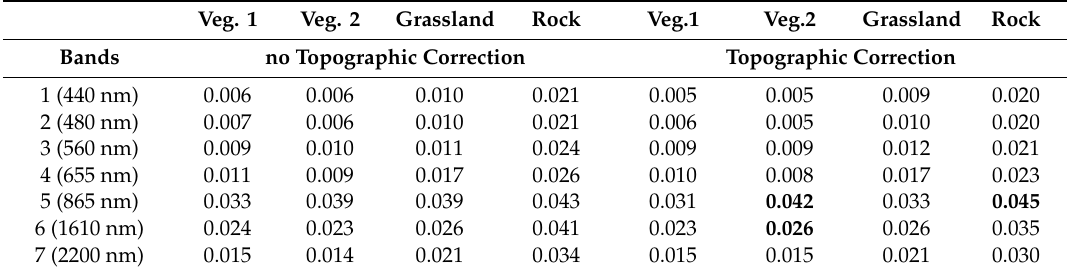
Table 2. Reflectance variance computed within the four cover classes excluding and including the topographic corrections. Bold values highlight the few values for wich an increase was observed after the inclusion of topographic corrections.